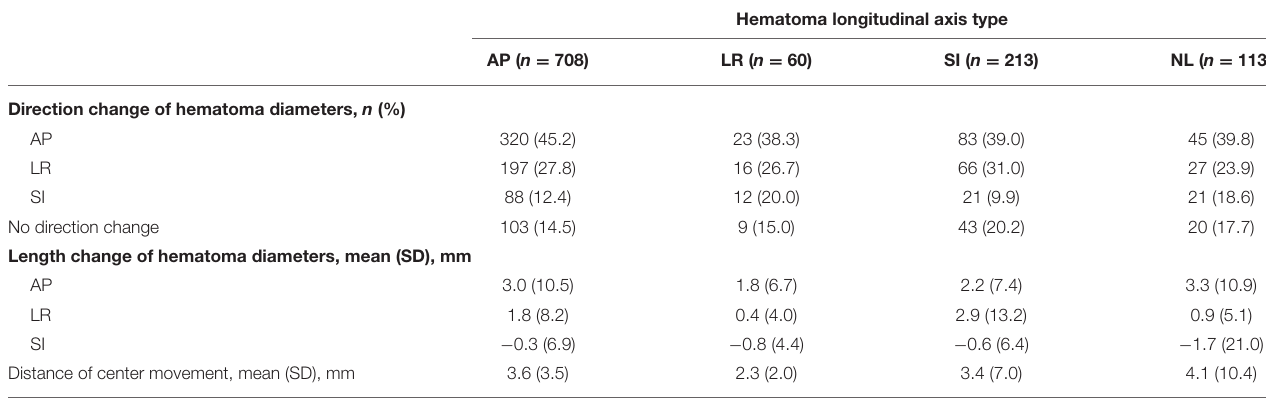
TABLE 3 | Morphological changes by longitudinal axis